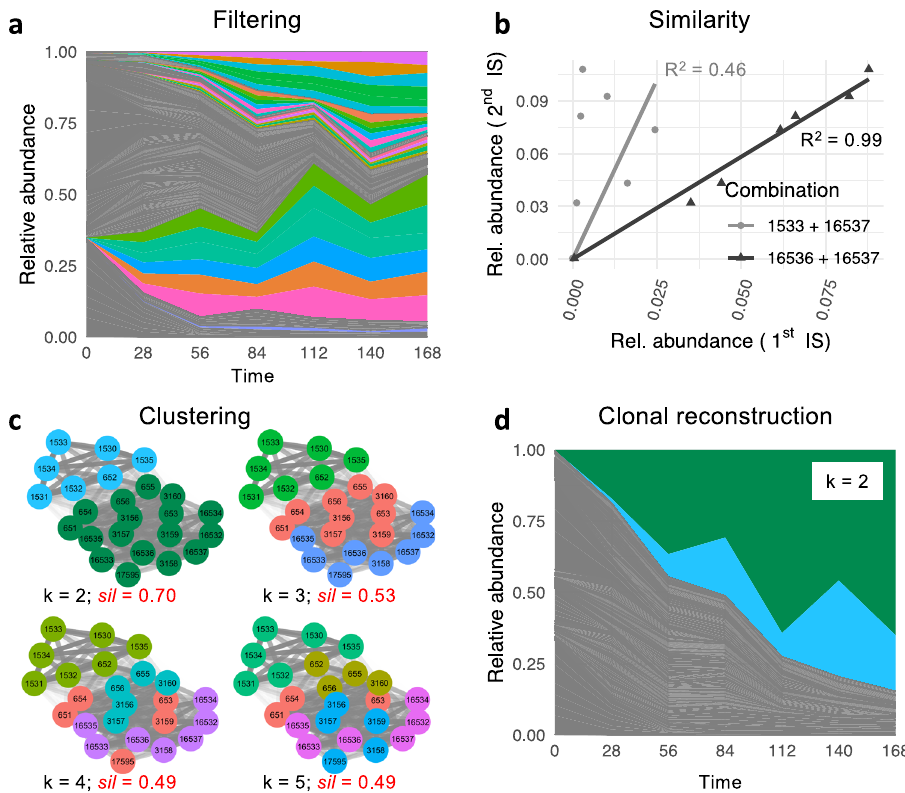
Fig. 2 Overview of the reconstruction pipeline. a Example of a time series of IS abundance after applying a fi ltering step (IS > 1% at the last time point). Gray colors indicate IS that did not pass the fi ltering. b Two examples for the calculation of the similarity score R 2 between two pairs of IS. The smaller residuals between triangles and the black line indicate a higher similarity between IS 16536 and 16537 ( R 2 = 0.99) as compared to IS 1533 and 16537 ( R 2 = 0.46), which are shown in gray and present with larger residuals. c Network representations of the corresponding similarity matrix S in which the shading of the edges indicates the mutual correlation between the IS. We show four different clusterings for increasing values of clusters k = 2 to 5, for which the coloring of the nodes represents the obtained clustering. Using the silhouette score sil (provided in red) we compare the overall clustering quality between these results, indicating that for the particular data set, k = 2 clusters optimally re fl ect the structure of the similarity matrix S . d The clonal time series which has been reconstructed by assigning IS of one cluster to the same clone. IS that did not pass the fi ltering, are still shown in